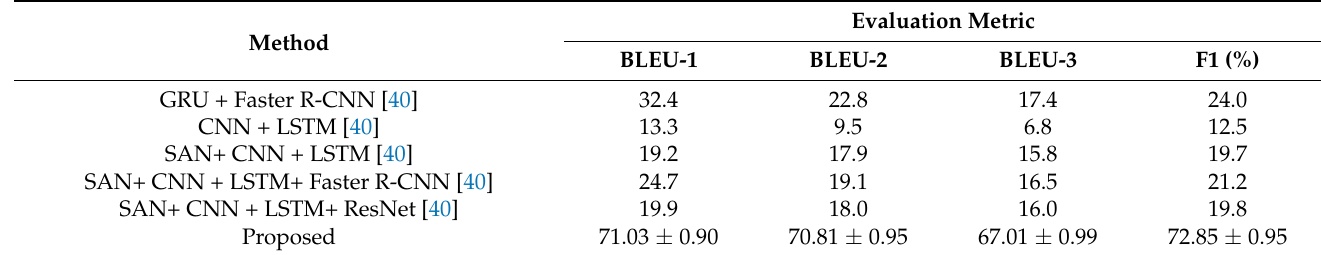
Table 4. BLEU-1, 2, 3 and F1 on open-ended questions.